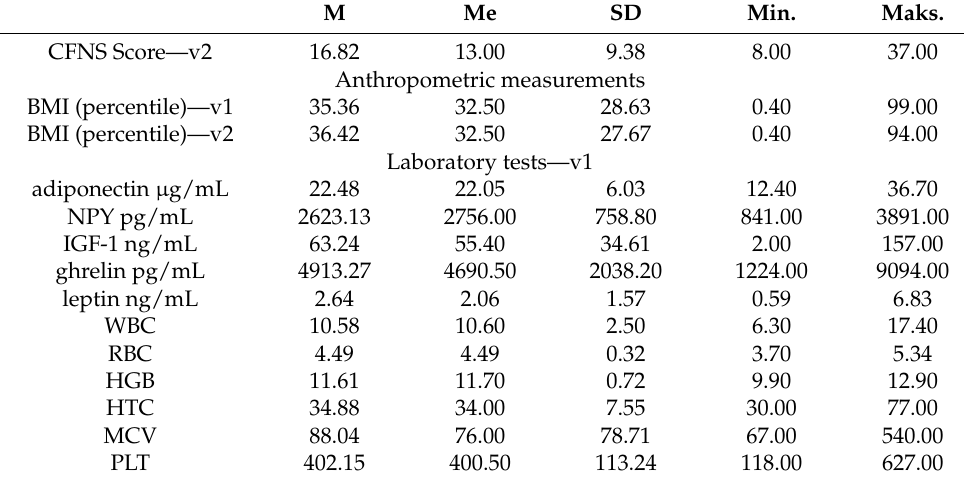
Table 2. Descriptive characteristic of prospective group (n = 50).